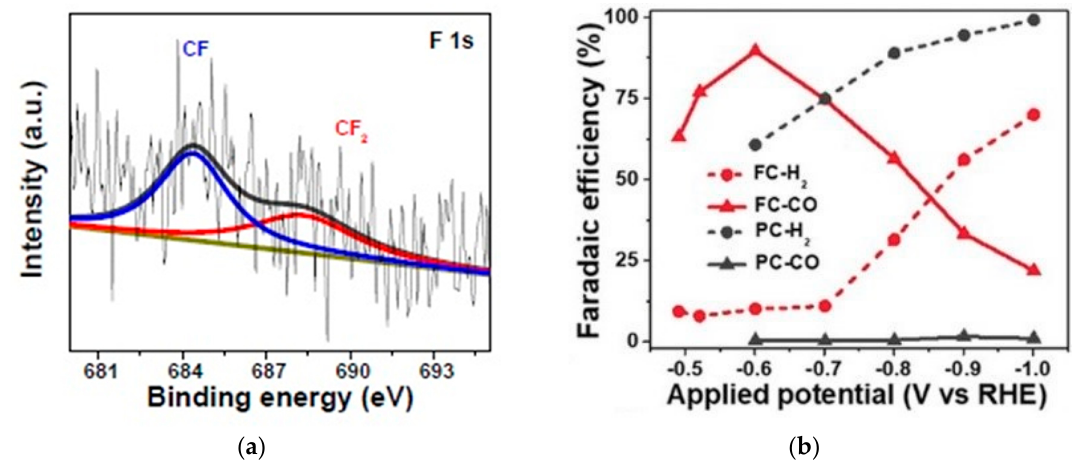
Figure 8. ( a ) High-resolution X-ray photoelectron spectroscopy (XPS) spectrum of F 1s for the FC catalyst. ( b ) Faradaic efficiency to CO and H 2 as a function of the applied potential on FC compared with PC (pristine carbon), reproduced from [115], Copyright (2020), with permission from John Wiley and Sons.